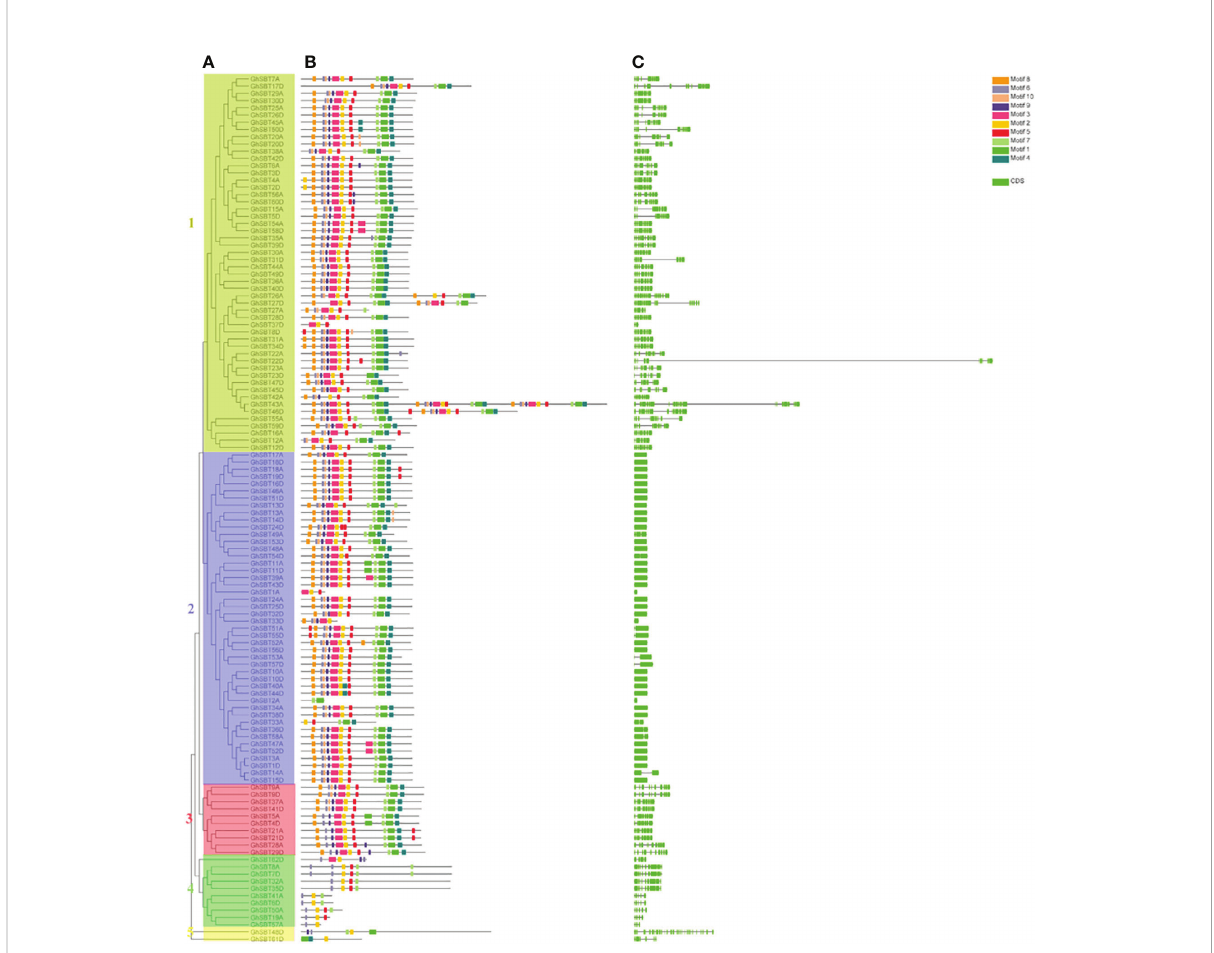
FIGURE 3 Genetic structure of the SBT gene family in upland cotton. (A) Phylogenetic tree of the SBT gene family. (B) Motif pattern diagram of the SBT gene family. (C) Exon structure diagram of the SBT gene